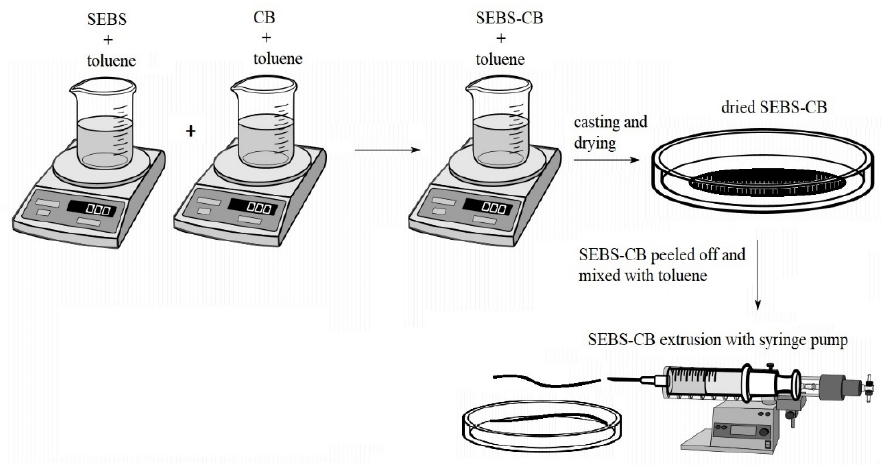
Figure 13. Illustration of a stretchable and flexible SEBS/CB strand preparation.